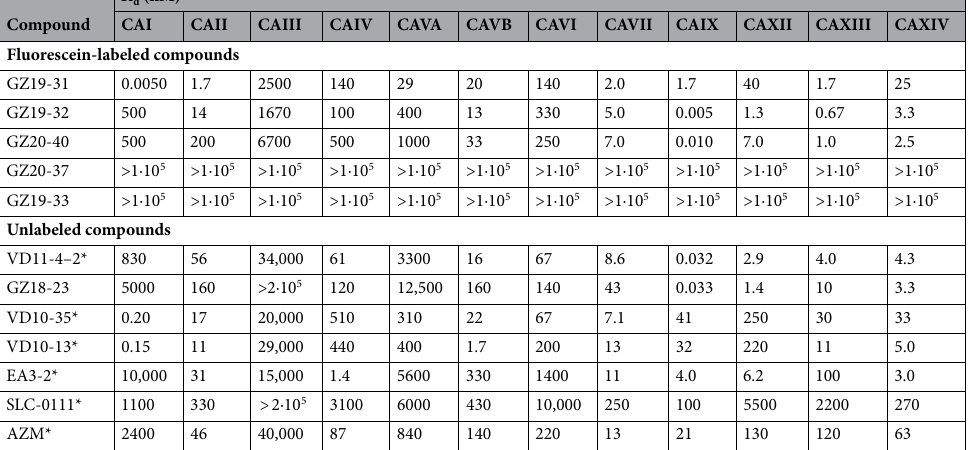
Table 1. Dissociation constants of the fluorescein-labeled CA inhibitors and non-labeled inhibitors (chemical structures shown in Fig. 1). We also determined the affinities of the commonly used inhibitors SLC-0111 and acetazolamide (AZM) as controls of the assay. The dissociation constants are the observed ones (not intrinsic ), given in nM units, determined by the TSA for 37 °C at pH 7.0 *The K d values for VD11-4-2, VD10-35, VD10- 13, EA3-2, and AZM were taken from 29 . The K d values for SLC-0111 binding to CAII and CAXII were taken from 30 .